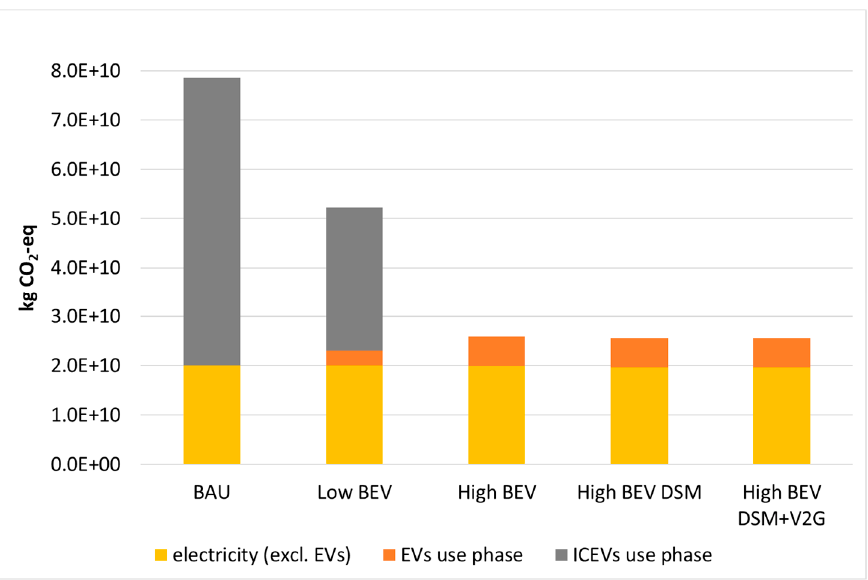
Figure 11. Cumulative greenhouse gas (GHG) emissions of domestic electricity supply to all non- transport sectors (yellow) + use phase of a 10 million LDV fleet. “BAU” = 10M ICEVs (grey); “Low BEV” = 5M ICEVs (grey) + 5M BEVs (orange); “High BEV,” “High BEV DMS” and “High BEV DMS+V2G” = 10M BEVs (orange).